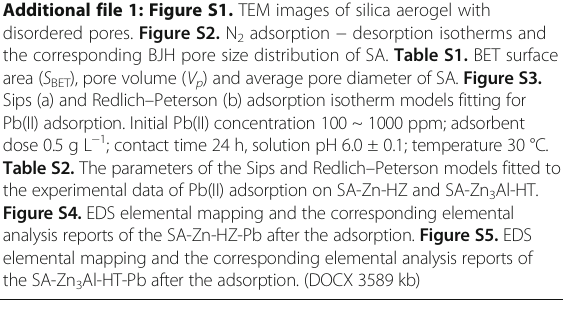
Additional file 1: Figure S1. TEM images of silica aerogel with disordered pores. Figure S2. N 2 adsorption − desorption isotherms and the corresponding BJH pore size distribution of SA. Table S1. BET surface area ( S BET ), pore volume ( V p ) and average pore diameter of SA. Figure S3. Sips (a) and Redlich – Peterson (b) adsorption isotherm models fitting for Pb(II) adsorption. Initial Pb(II) concentration 100 ~ 1000 ppm;